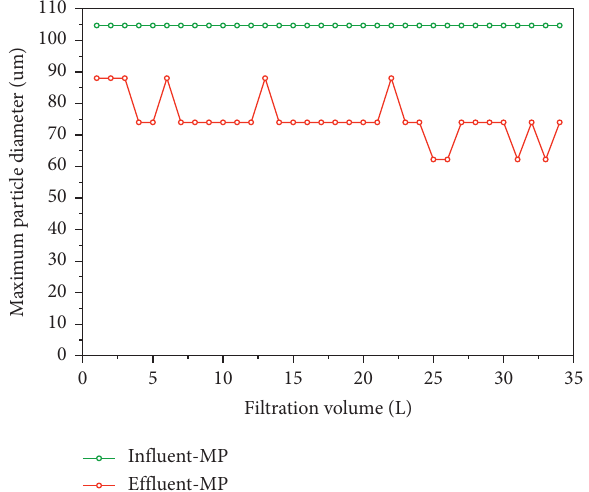
Figure 9: Changes of the maximum particle diameter of influent and effluent with different filtration